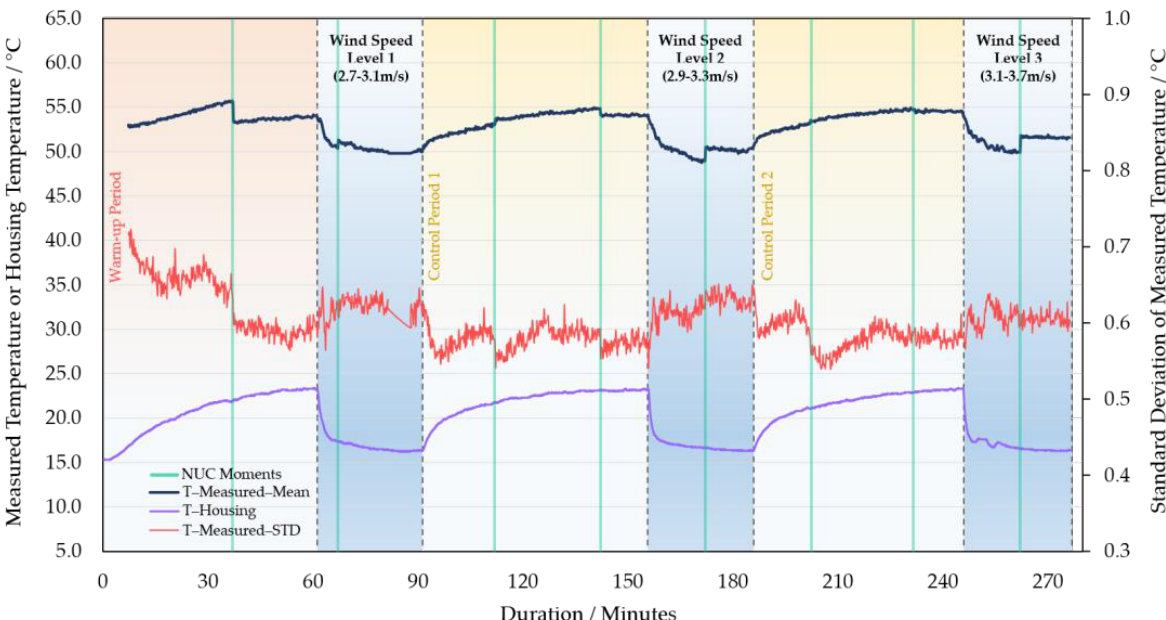
Figure 11. Simulation of the effect of wind on WIRIS while imaging a blackbody at 55 °C with three levels of wind speeds (lowest — 2.7 – 3.1 m/s, medium — 2.9 – 3.3 m/s, highest — 3.1 – 3.7 m/s). One-hour control periods were set between wind tests. The housing temperature’s development (of the camera) and the STD of the measured temperature are also included.